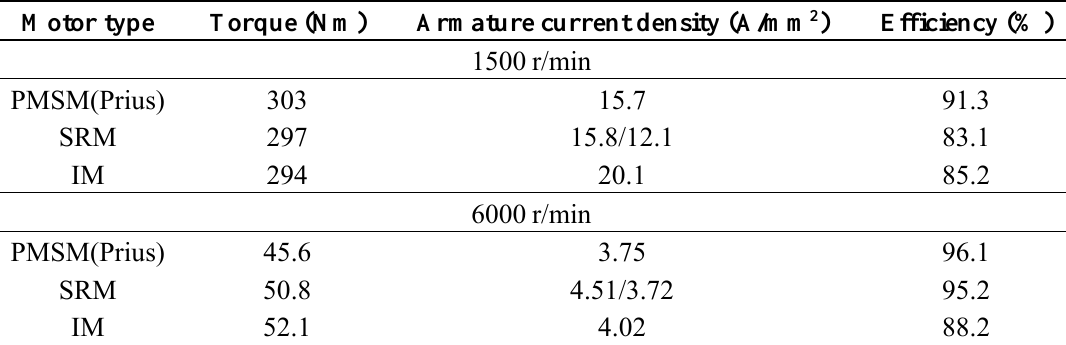
Figure 3. Three popular motors in EV: Induction machines (IM), switched reluctance machines (SRM) and permanent magnet synchronous machines (PMSM). Table 2. Comparison of three kinds of